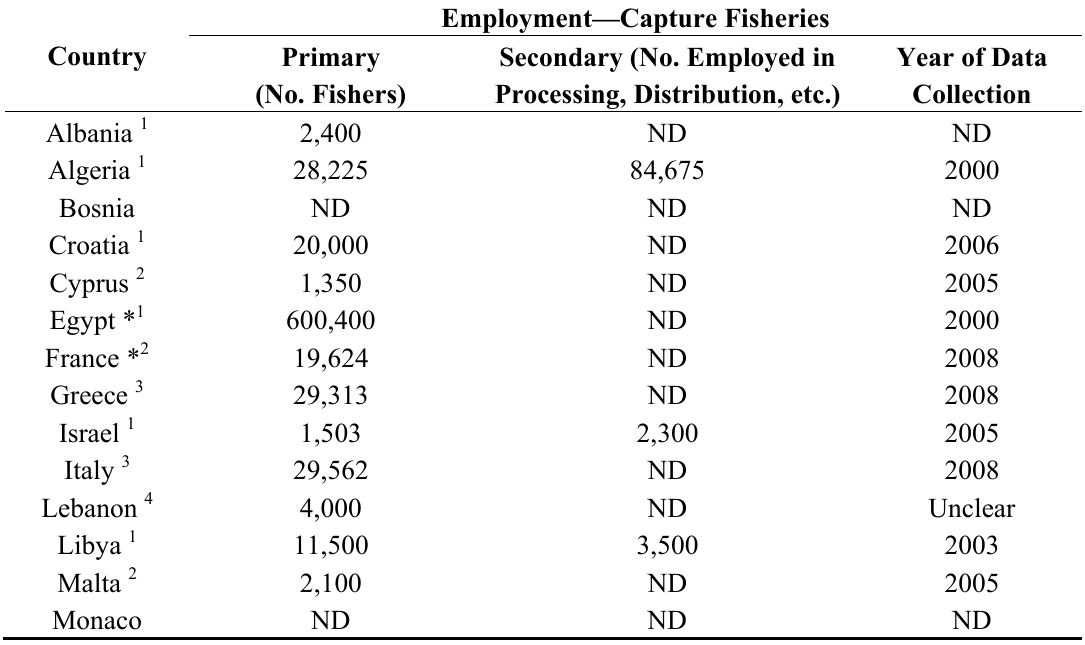
Table 4. Employment in fisheries. Numbers in italics are estimates. Asterisk indicates that it is not clear what proportion of these fishers operate in the Mediterranean. ( 1 [46]; 2 [45]; 3 [64]; 4 [54]